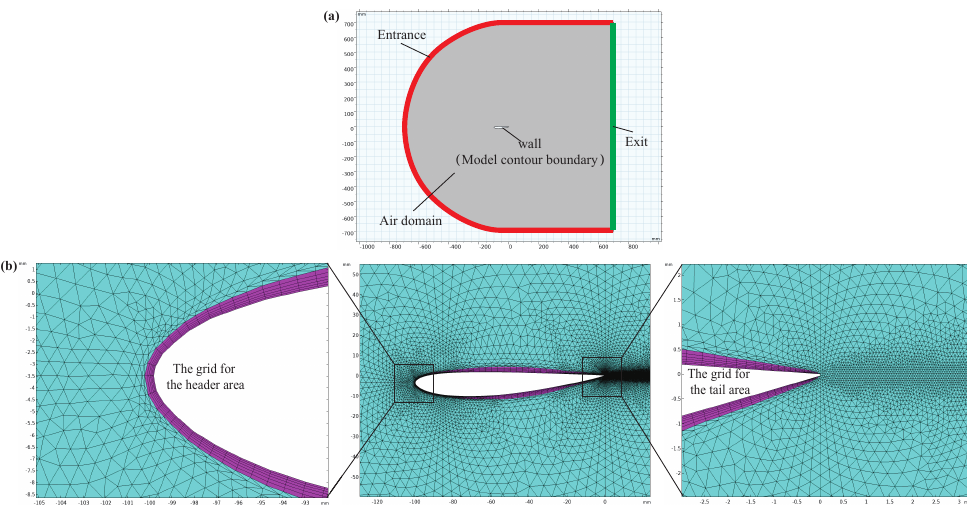
Figure 11. Simulation parameter setup, including ( a ) air domain setting and ( b ) mesh generation of the section abstract